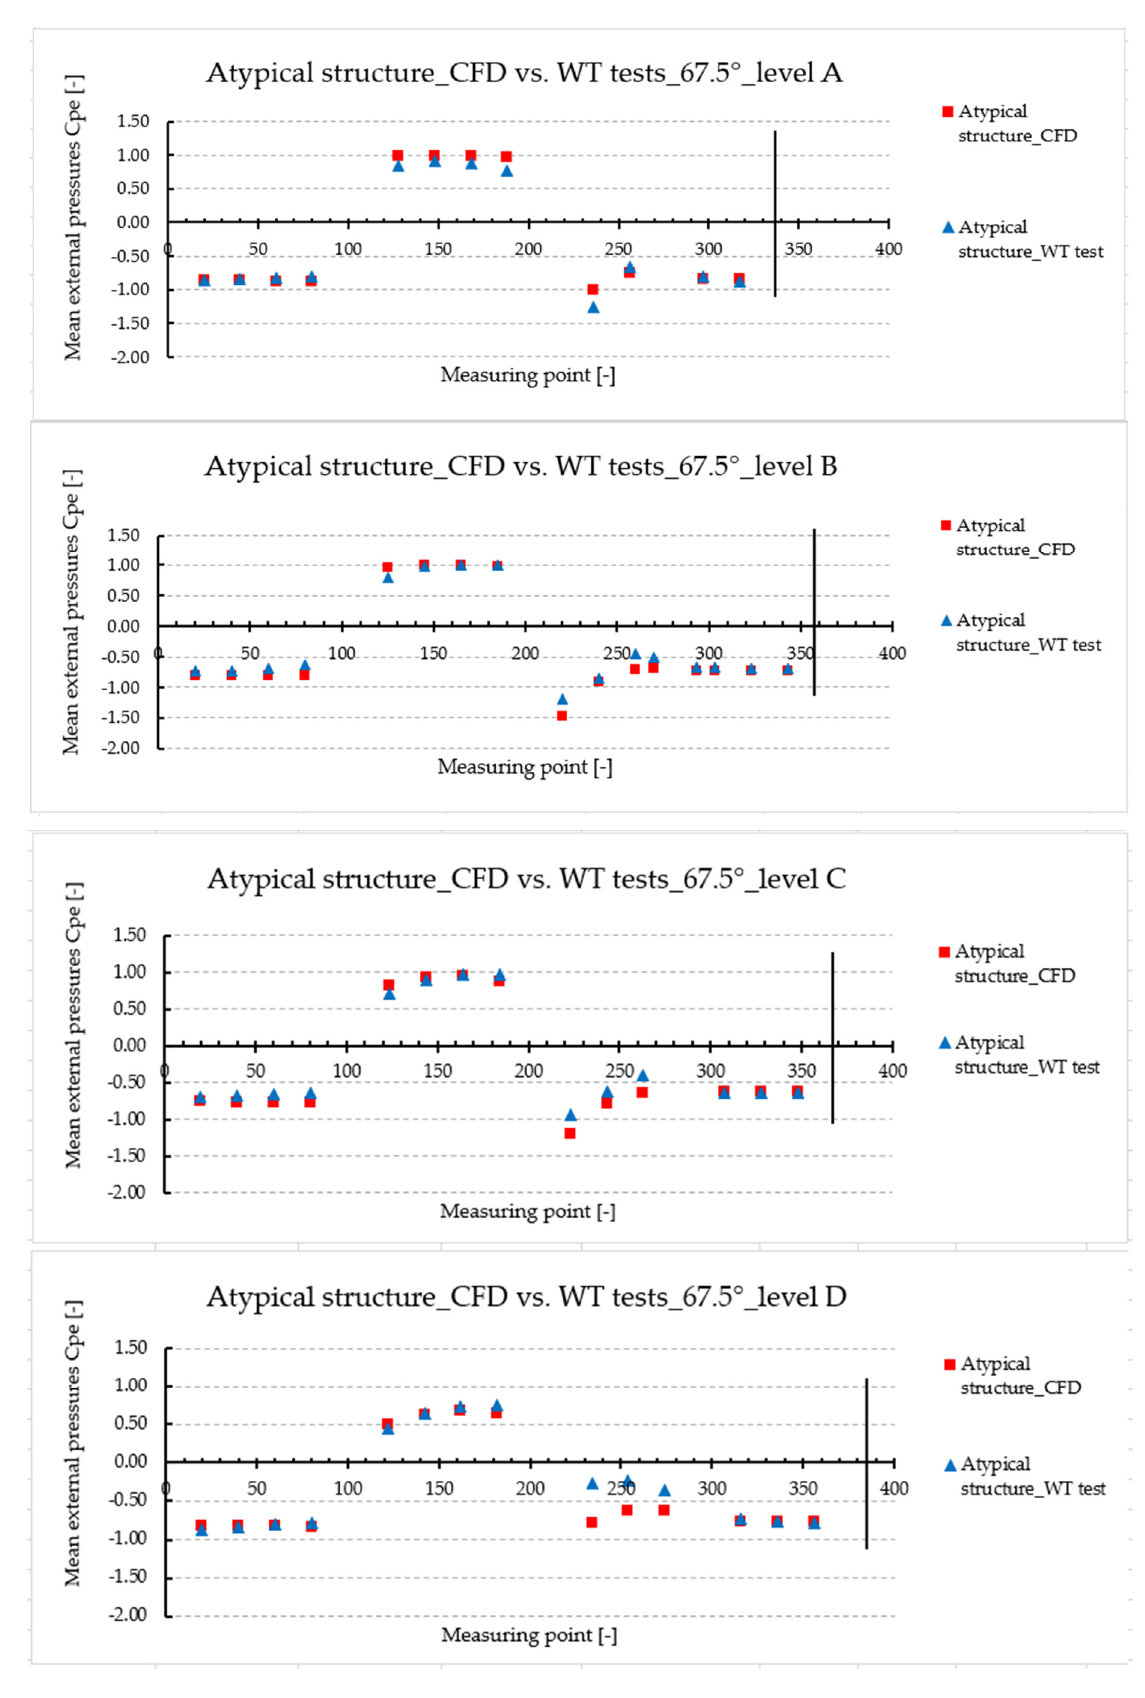
Figure 17. Mean values of c pe determined for the atypical structure—wind direction 67.5°.